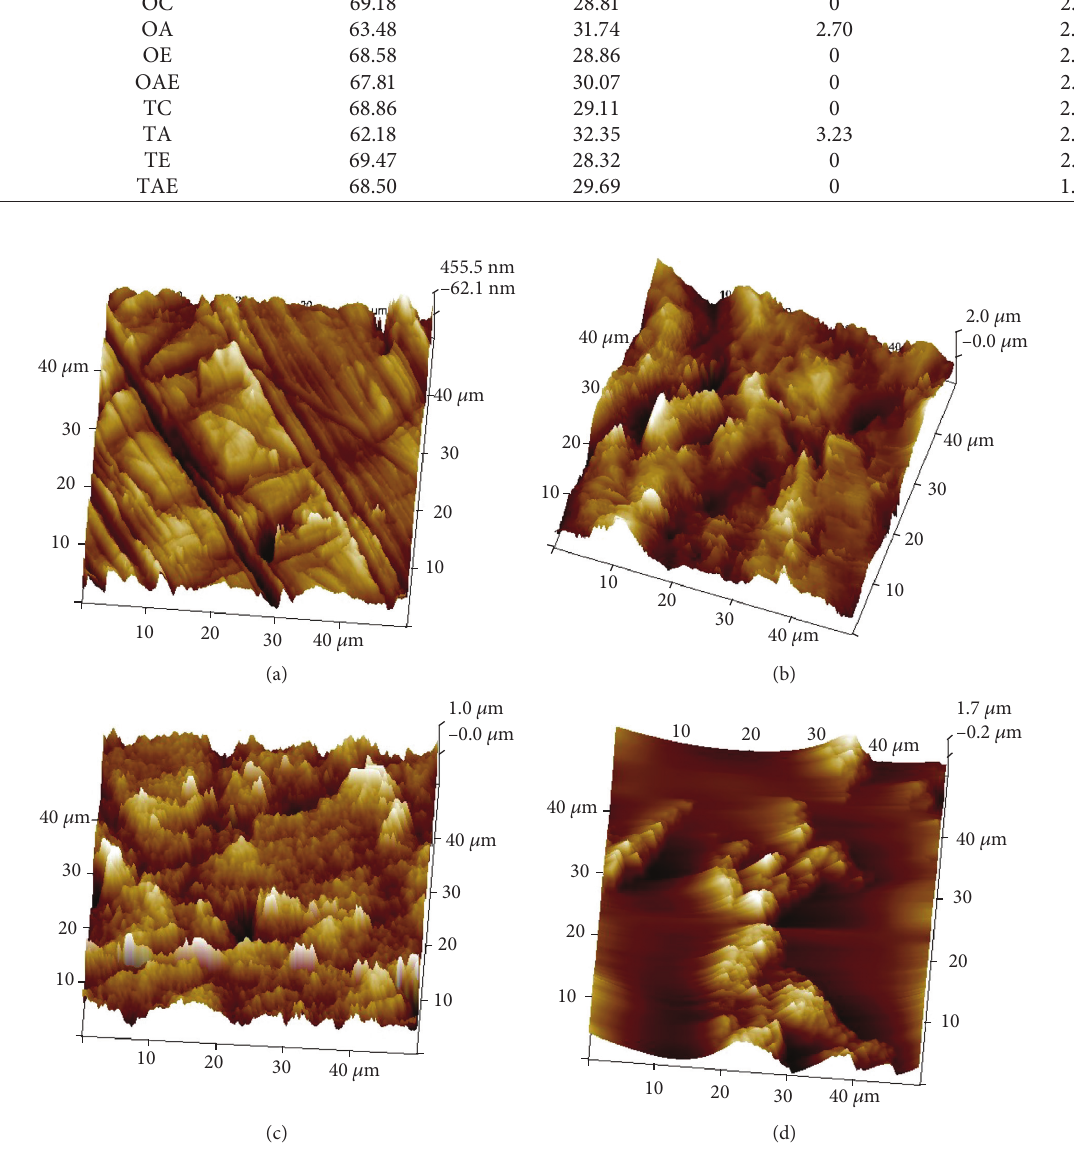
Figure 6: AFM images. (a) Group OC, (b) Group OA, (c) Group OE, and (d) Group OAE.